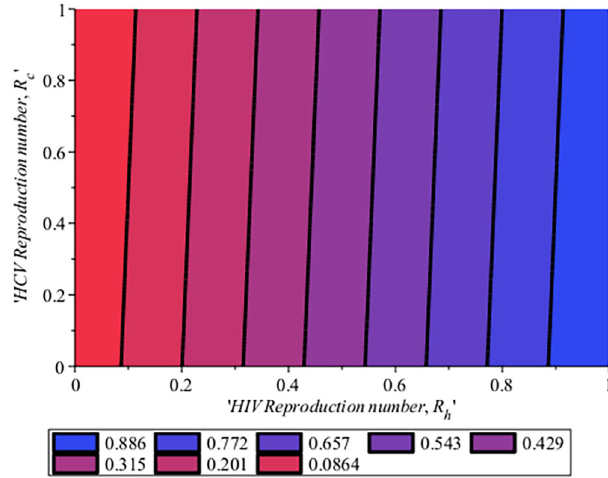
Figure 17. Impact of HIV reproduction number on HCV reproduction number.